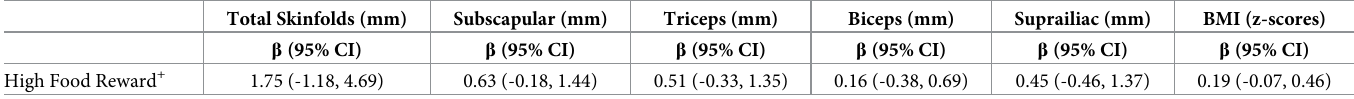
Table 3. Associations between food reward at 6 years old and child adiposity at 7 years old (n = 398). Total Skinfolds